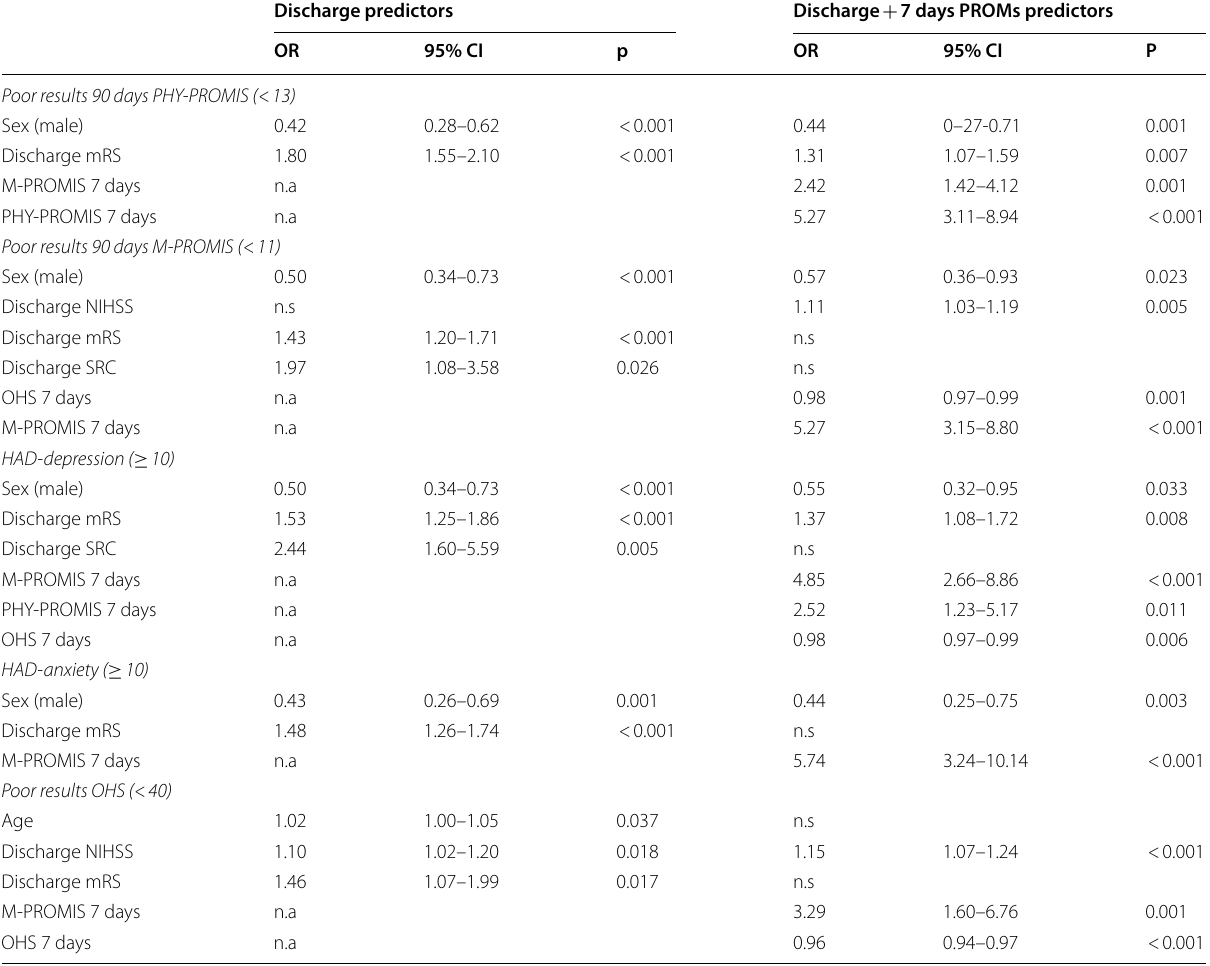
Table 2 Significant 3 months‑PROMs predictors in two multivariate regression